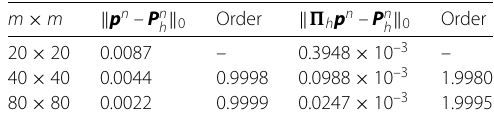
Table 5 Numerical results at t = 0.25 with τ = 5